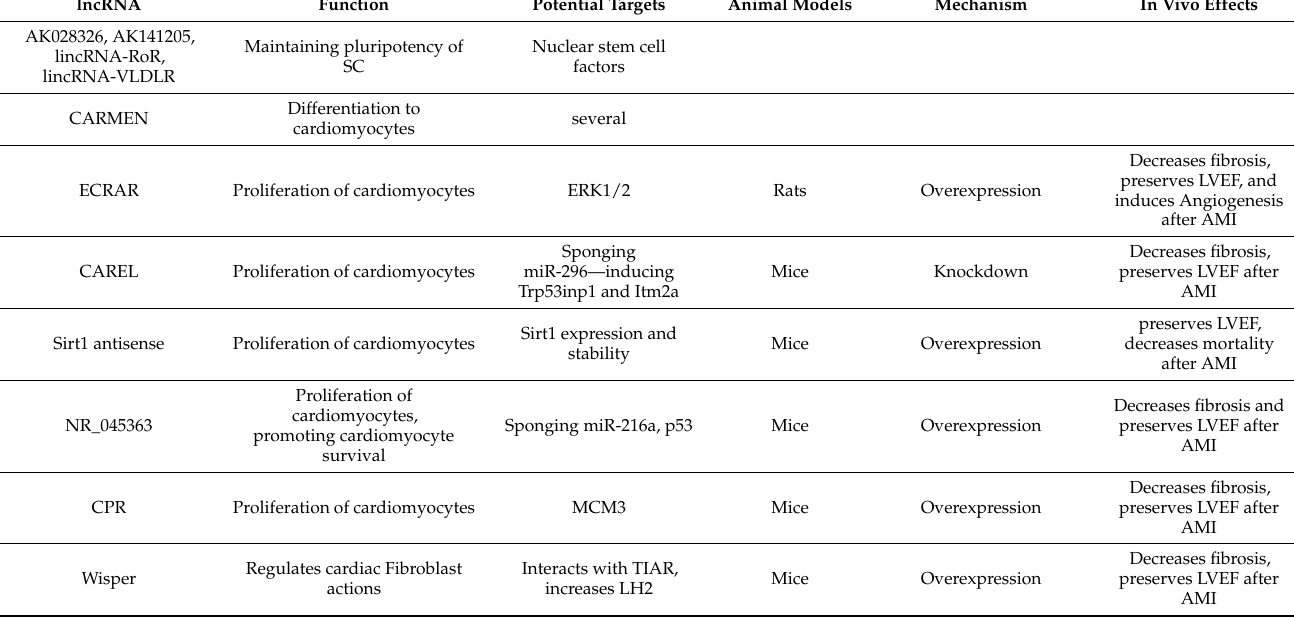
Table 2. Summary of linear lncRNAs considered to be involved in stem cell regulation and cardiac regeneration.